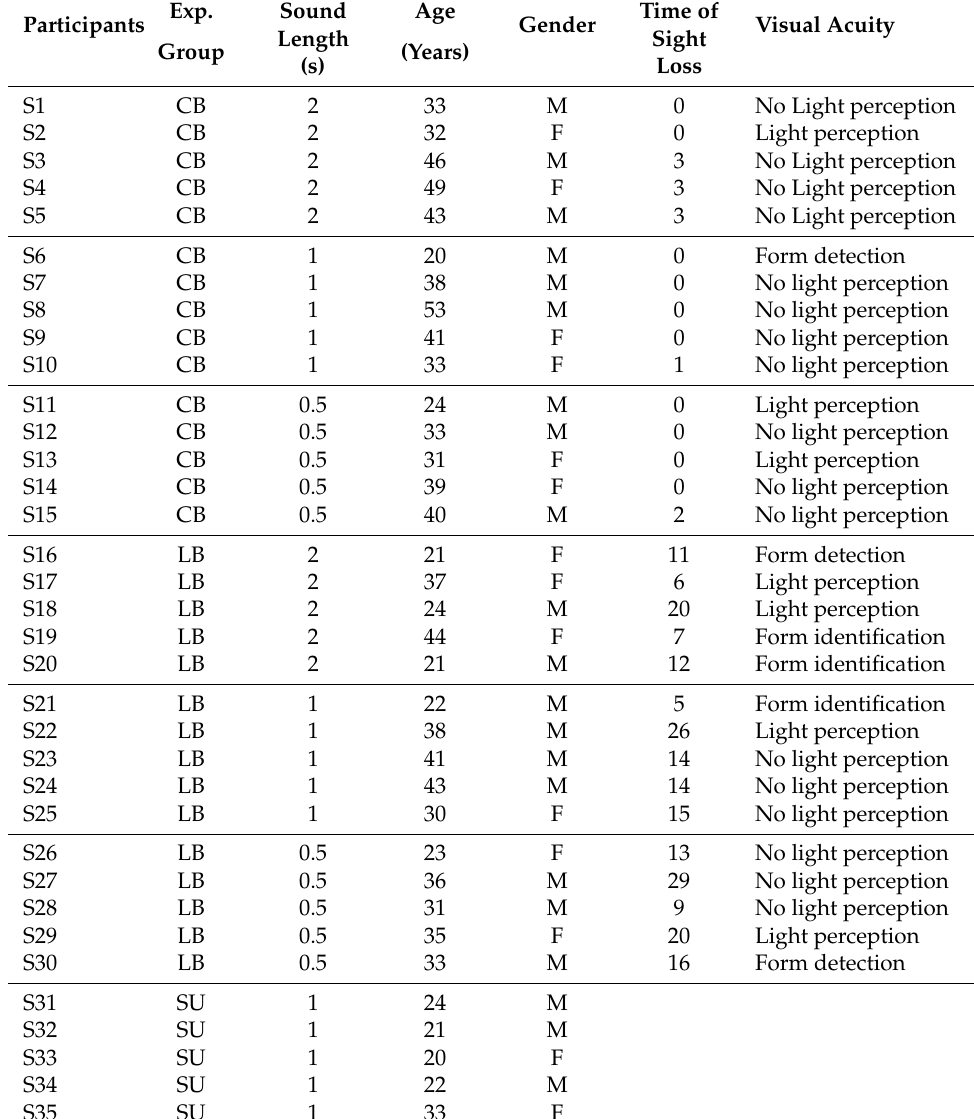
Table 2. Demographic information of participants for main